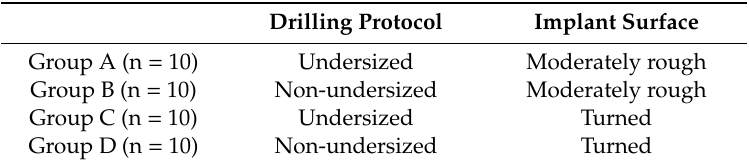
Table 1. Description of the experimental